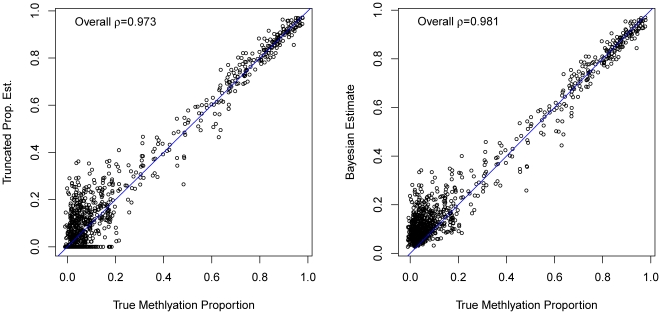
Performance of proposed estimates on simulation data at sequencing depth 50.Comparison of the proposed estimates (TPE and Bayesian Estimate) and the true methylation proportions in simulation. Bayesian estimate have significantly higher correlation (pearson  = 0.981) than TPE (pearson  = 0.973) (p-value<0.001, t test).